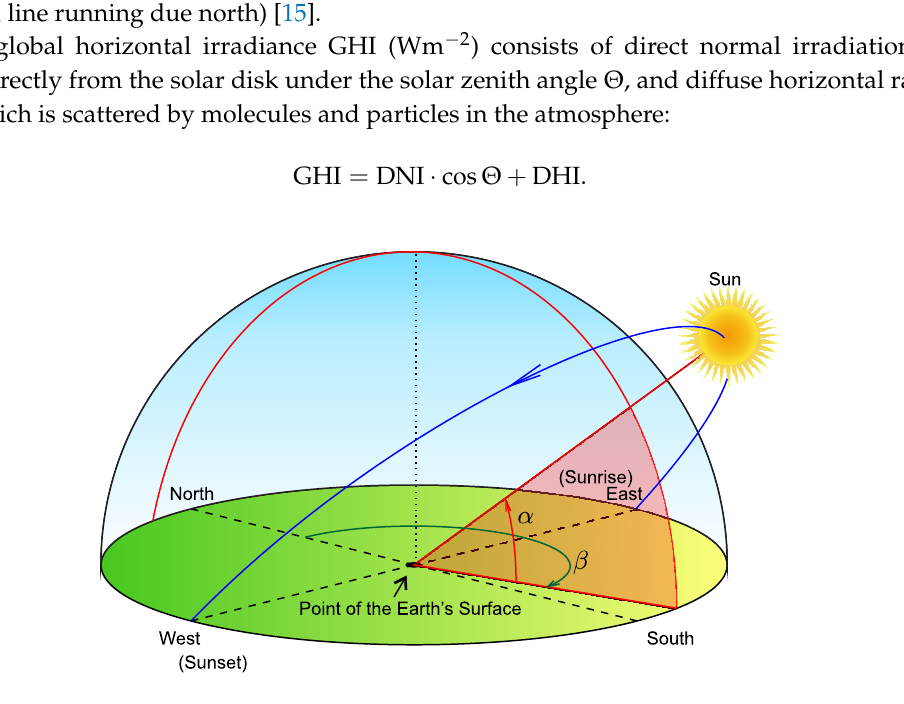
Figure 2. Illustration of the position of the solar disk for maximum efficiency, adapted from